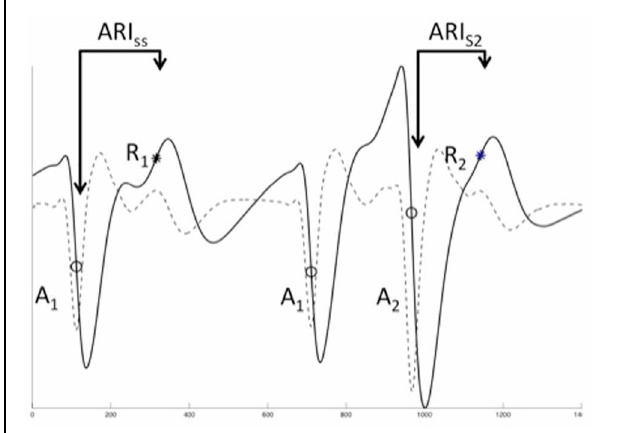
FIGURE 1 | Unipolar EGM analysis. The three final of a restitution train are shown, typical unipolar electrograms (solid line) and their differential (dashed line). Local activation was defined as the most rapid downstroke (dVdtmin, circles, A 1 , A 2 ) of the activation inscription, repolarization was defined using the classical (Wyatt) method as dVdtmax of the T-wave (asterisks, R 1 , R 2 ). Activation time was defined as the time from pacing stimulus (not shown) to local activation, ARI as time from local activation to repolarization. It was not possible to reliably measure the diastolic interval for close coupled beats, therefore DI was taken as A 1 A 2 —ARI ss